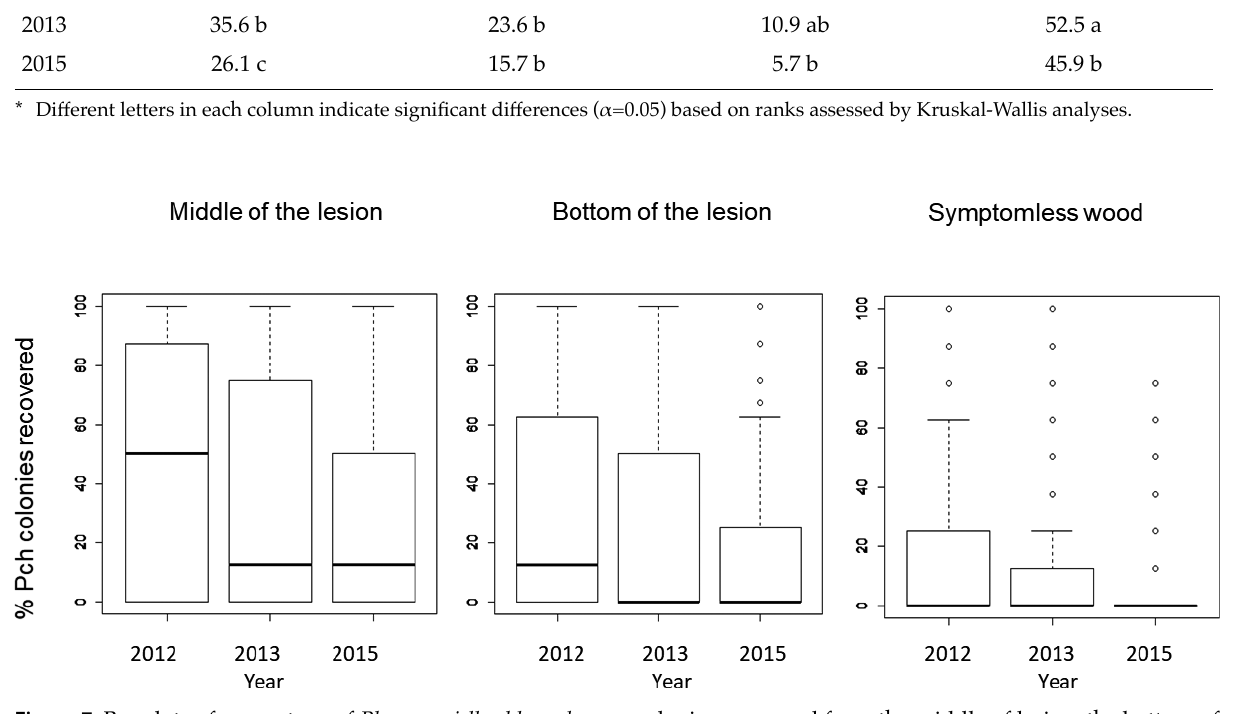
Figure 7. Boxplots of percentage of Phaeomoniella chlamydospora colonies recovered from the middle of lesion, the bottom of the lesion or from symptomless wood, for the three trial years 2012, 2013 or 2015. The median is represented by the solid